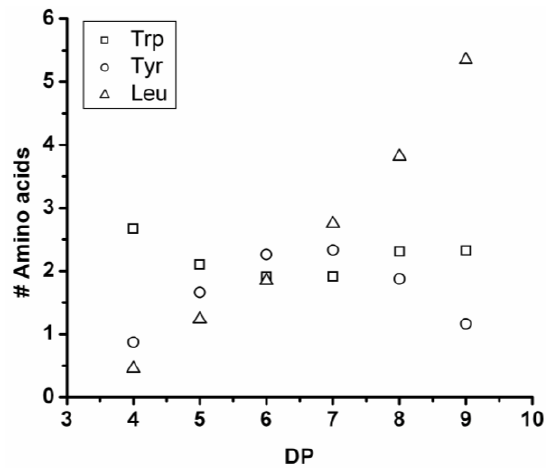
Figure 25. Average number of amino acids in